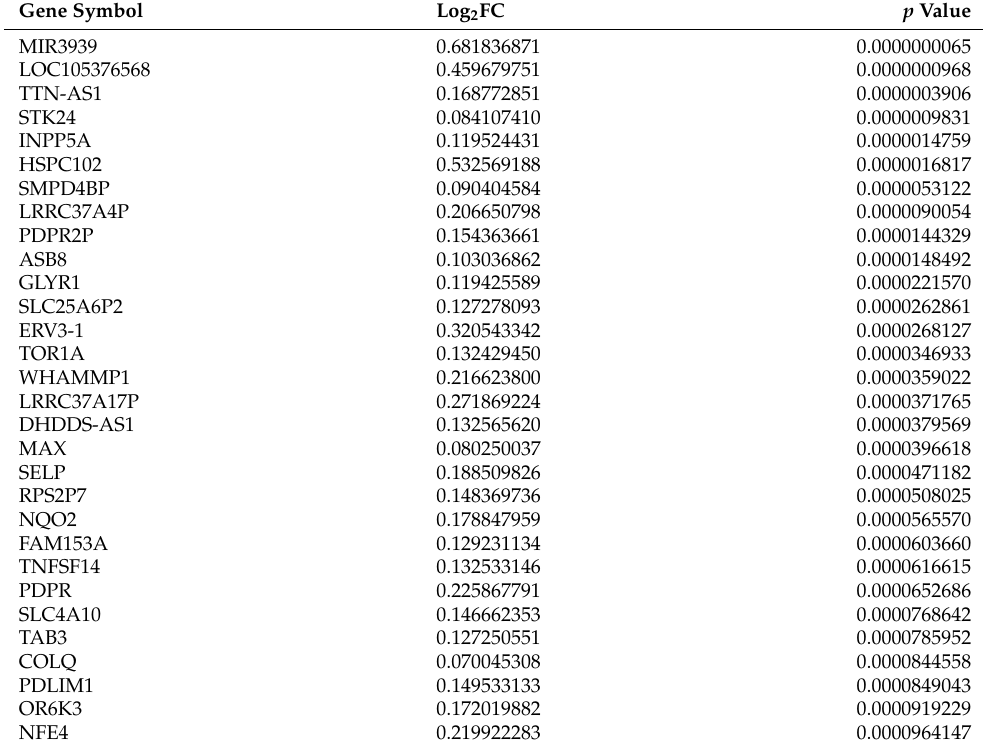
Table 2. Top 30 upregulated genes of the DEGs.